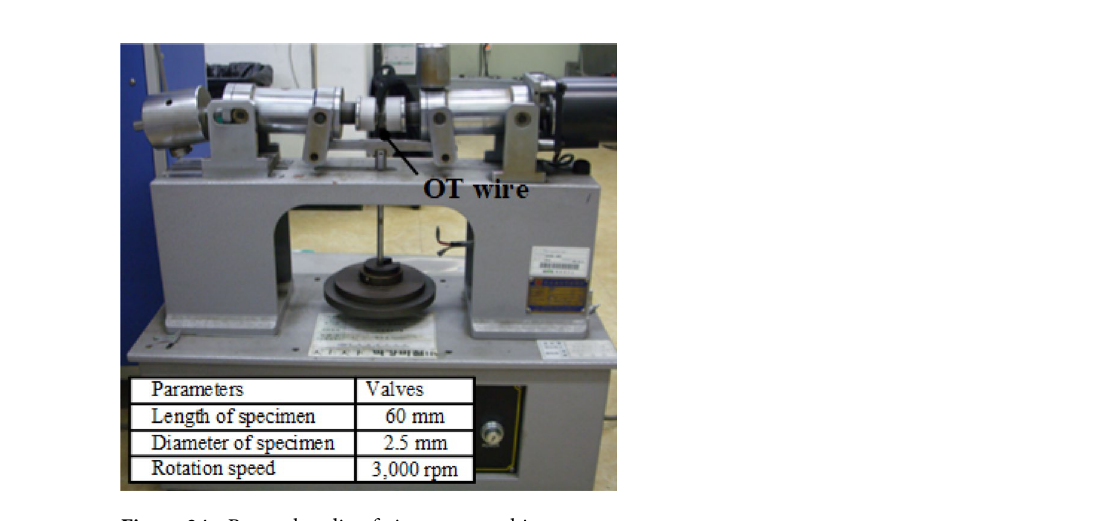
S–N curve application and life prediction. Figure 25 shows the S–N curve of the OT wire derived through the rotary bending fatigue test. To evaluate the effect of the surface flaw on the fatigue life of the spring, the strength analysis results of the surface flaw derived in subsection 6.1 were applied to the Goodman equation to obtain equivalent bending stress. The valve springs of cases 1 through 13 with an initial flaw depth of 40 µm or less exhibited a fatigue strength of 1002 MPa or less. Therefore, the fatigue life of the valve spring with a wire diameter of 2.5 mm, which is the target of this study, is expected to be more than 10 8 cycles for surface flaws